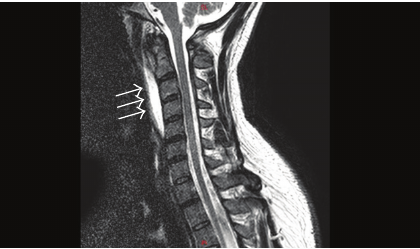
Figure 2: Sagittal T2-weighted MRI of the neck shows bright signal representing a prevertebral fluid